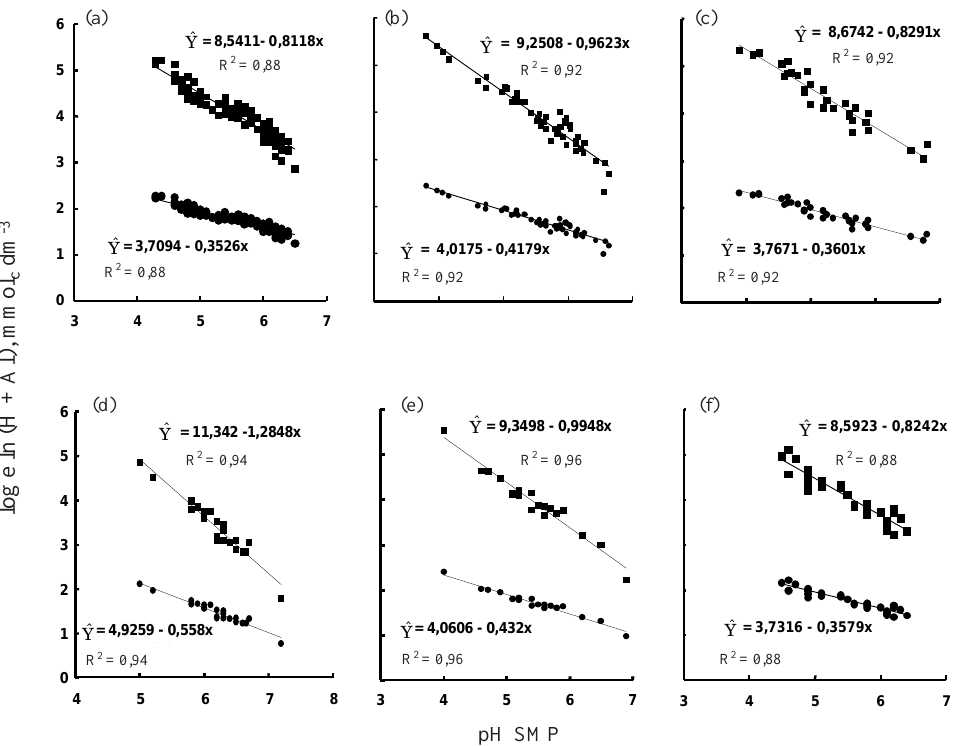
Figura 2. Relação entre o logaritmo decimal (•) e natural ( ) de H + Al e o pH SMP em solos do RS e de SC. Resultados obtidos pelo laboratório de solos da UPF (a), por Bissani (1985) (b), Ernani &